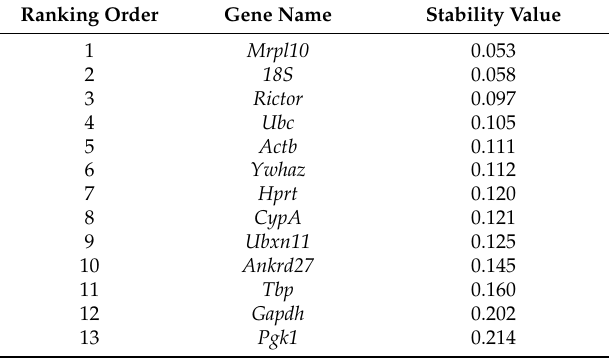
Table 2. NormFinder determined stability values of candidate housekeeping genes in distal sciatic nerve samples. Stability values of tested housekeeping genes were calculated by NormFinder software and then ranked. The lower the stability value, the higher the gene stability.